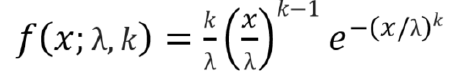
Figure 3. The probability density function of a Weibull random